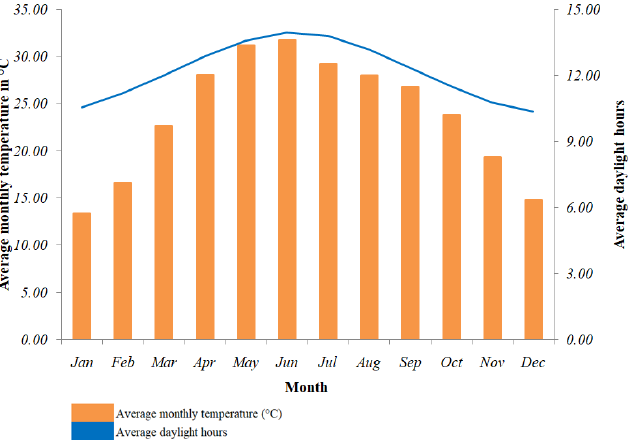
Figure 4. Average monthly temperature and daylight hours of the selected region.